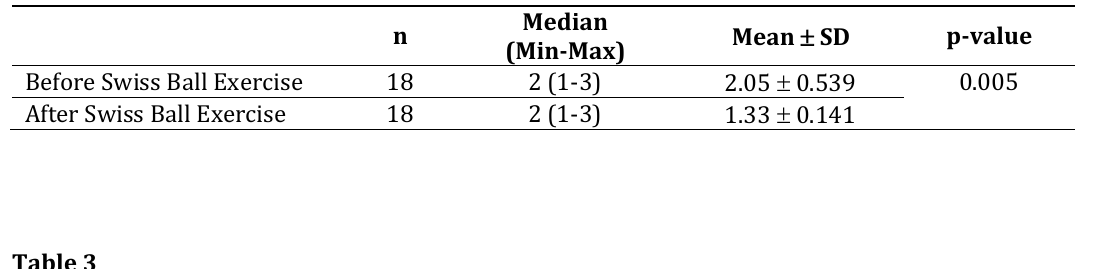
Wilcoxon Test Results with Time Up and Go Test in Intervention Group n